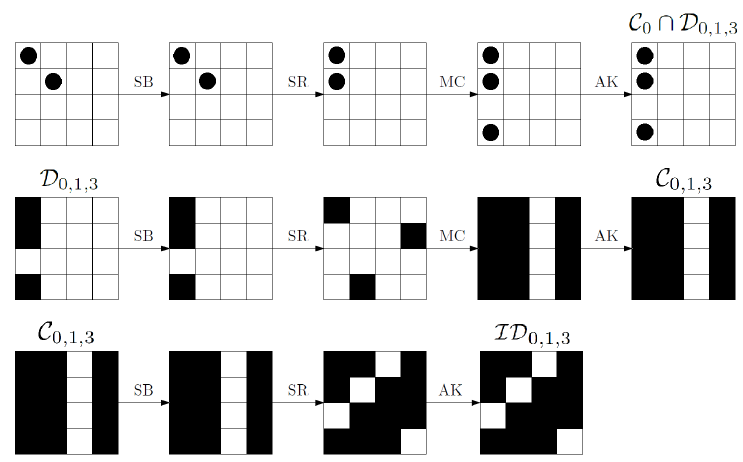
Figure 9: 3-rounds Truncated Differential Attack on AES with a single secret S-Box . The choice of the plaintexts (i.e. p 0 , 0 ⊕ p 1 , 1 = k 0 , 0 ⊕ k 1 , 1 ) guarantees that after one round there are only three bytes with non-zero difference instead of four, that is the plaintexts belong to the same coset of C 0 ∩ D 0 , 1 , 3 . White box denotes denotes a byte with a zero-difference, while a black box denotes a byte with non-zero